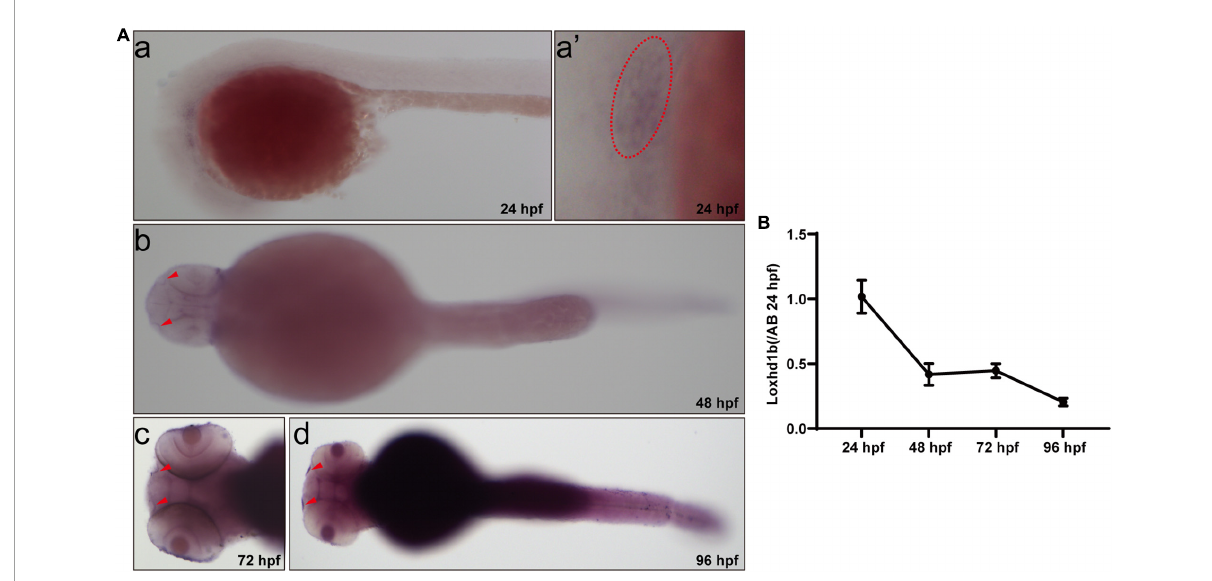
FIGURE1 Expression of Loxhd1b in zebrafish. (A) In situ hybridization revealing the Loxhd1b expression around the otic vesicles and Olfactory hole, indicating its contribution to hearing development. The arrows indicate the olfactory hole. The ellipse of dashed line indicates the otic vesicle. (B) Loxhd1b expression gradually decreased from 24 to 96